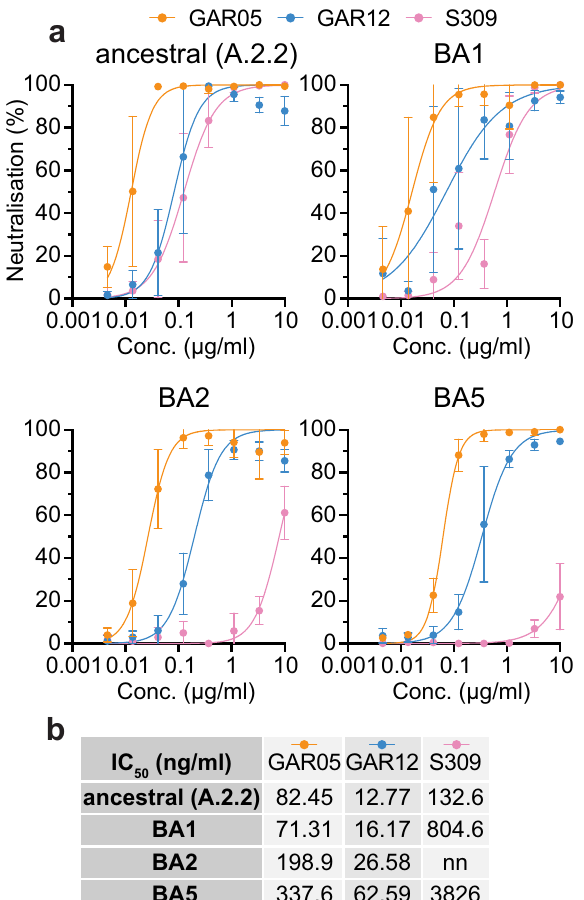
Fig. 5 | Neutralization of the Omicron VOCs. a SARS-CoV-2 neutralization (live virus), ancestral (A.2.2), Omicron VOCs BA1, BA2, BA5 ( n =4 technical replicates). b IC 50 values (ng/ml) reported for S309, GAR05 and GAR12 on ancestral and OmicronVOCs.nn=non-neutralizing.Dataarepresentedasmeanvalues+/-SDfor measurements performed over a range of concentrations. Source data are pro- vided as a Source Data fi